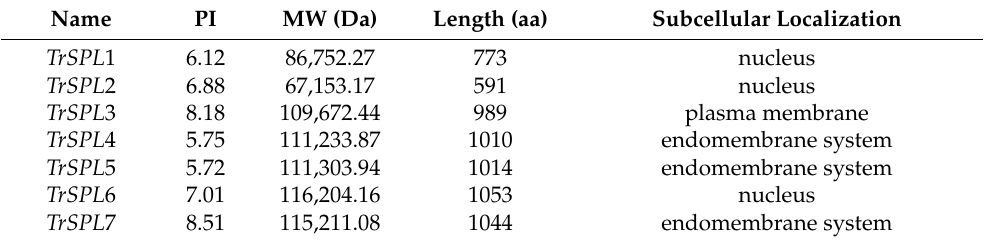
Table 1. The basic information and subcellular localization of all identified SPL genes in T. repens